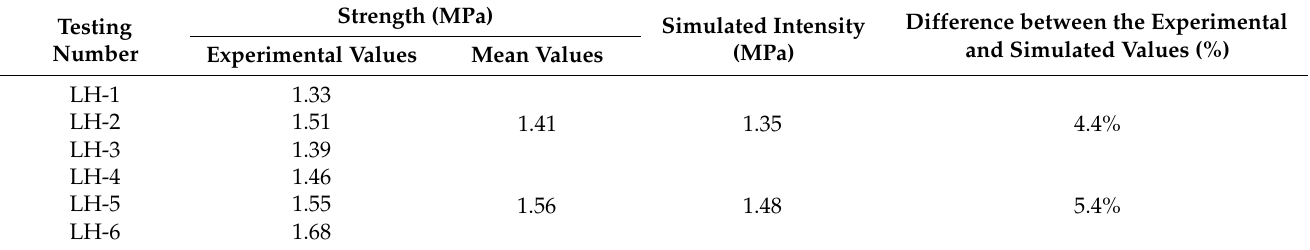
Figure 10. Load–displacement curves. ( a ) Horizontally printed specimen; ( b ) Vertically printed specimen. Table 19. Comparative analysis of axial tension test and numerical simulation.